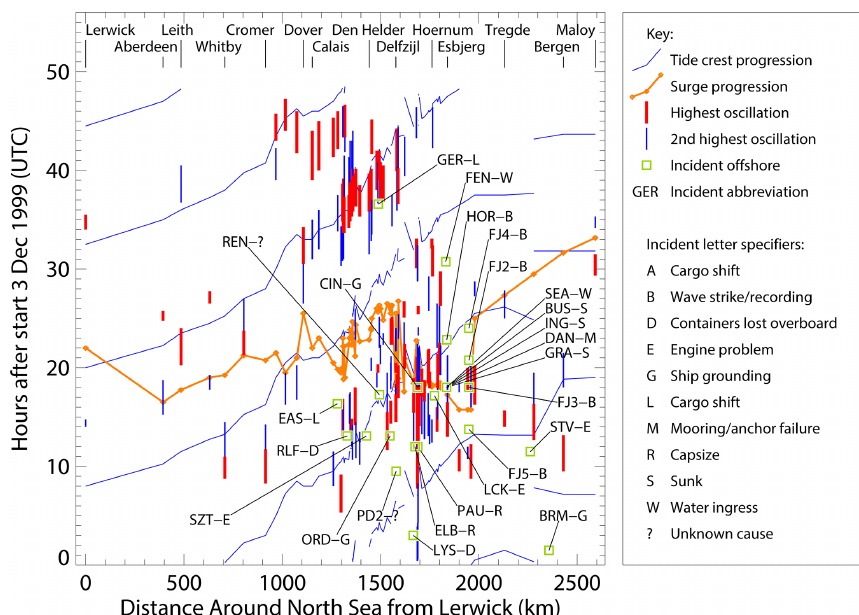
Figure 8. Summary of the progression of the tidal crests and storm surge peak around the North Sea on 3–4 December 1999, and spatial- temporal relationship of peak-to-trough range of the highest up-crossing short period oscillations in the tide gauge record and maritime incidents/accidents. The data are plotted on axes of time versus counter-clockwise distance around the North Sea starting from Lerwick in